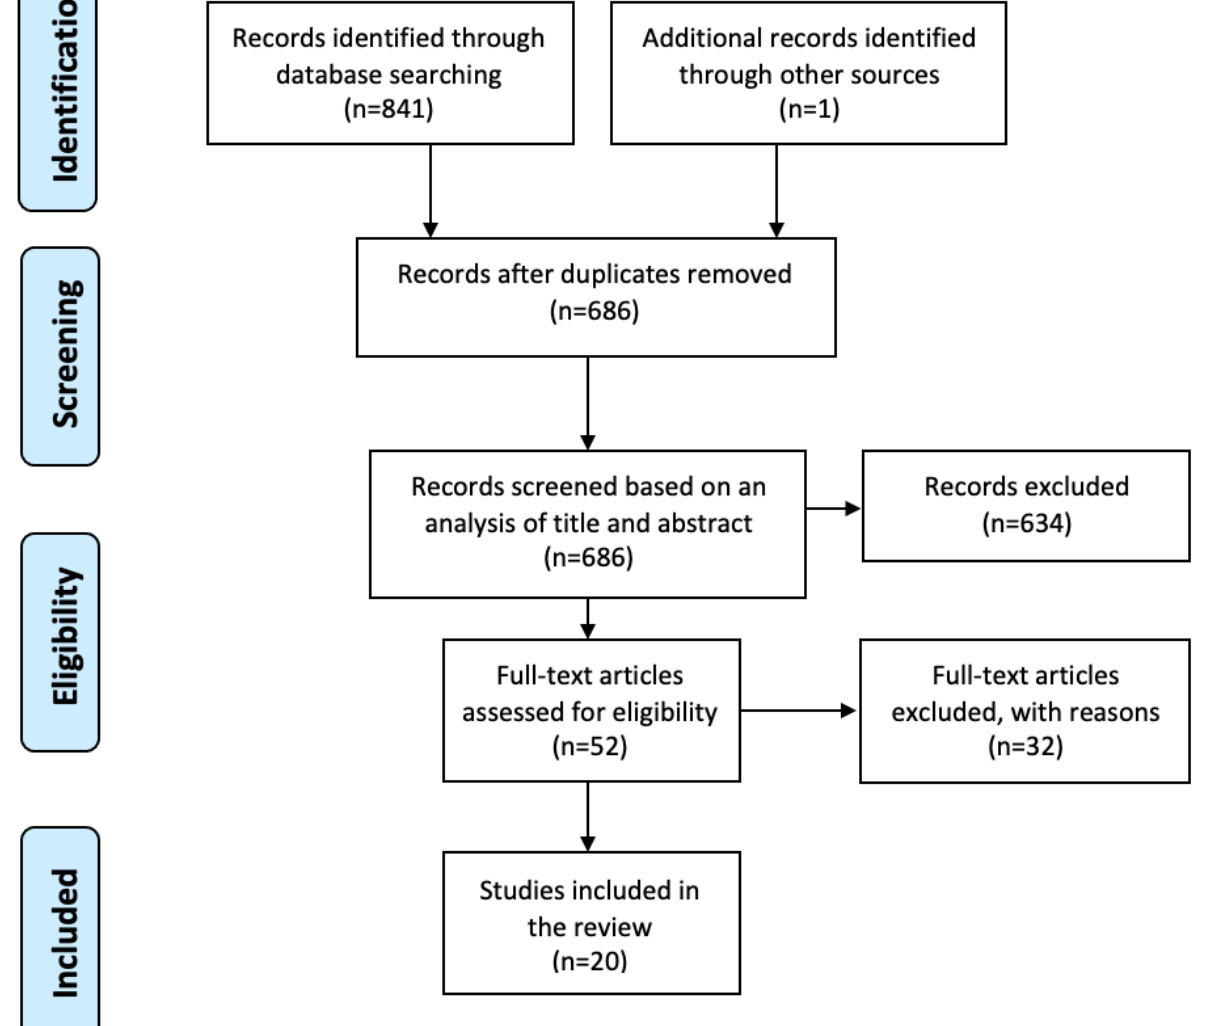
Figure 5. PRISMA (Preferred Reporting Items for Systematic Reviews and Meta-analyses) guidelines flow diagram depicting how many records were identified, screened, assessed, and included in the